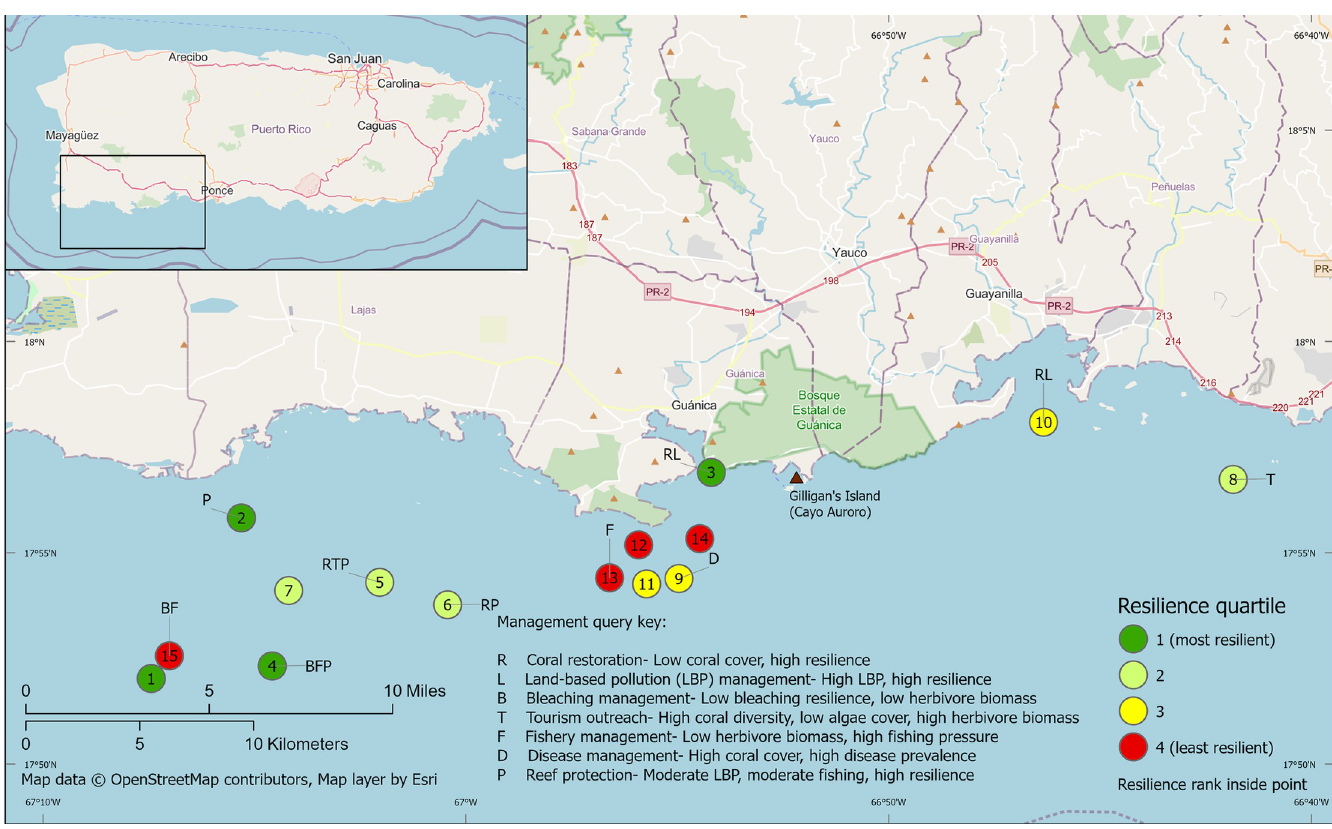
Fig 4. Reef resilience assessment for southwest Puerto Rico, including sites’ resilience ranks (1–15) and potential management actions at each site.